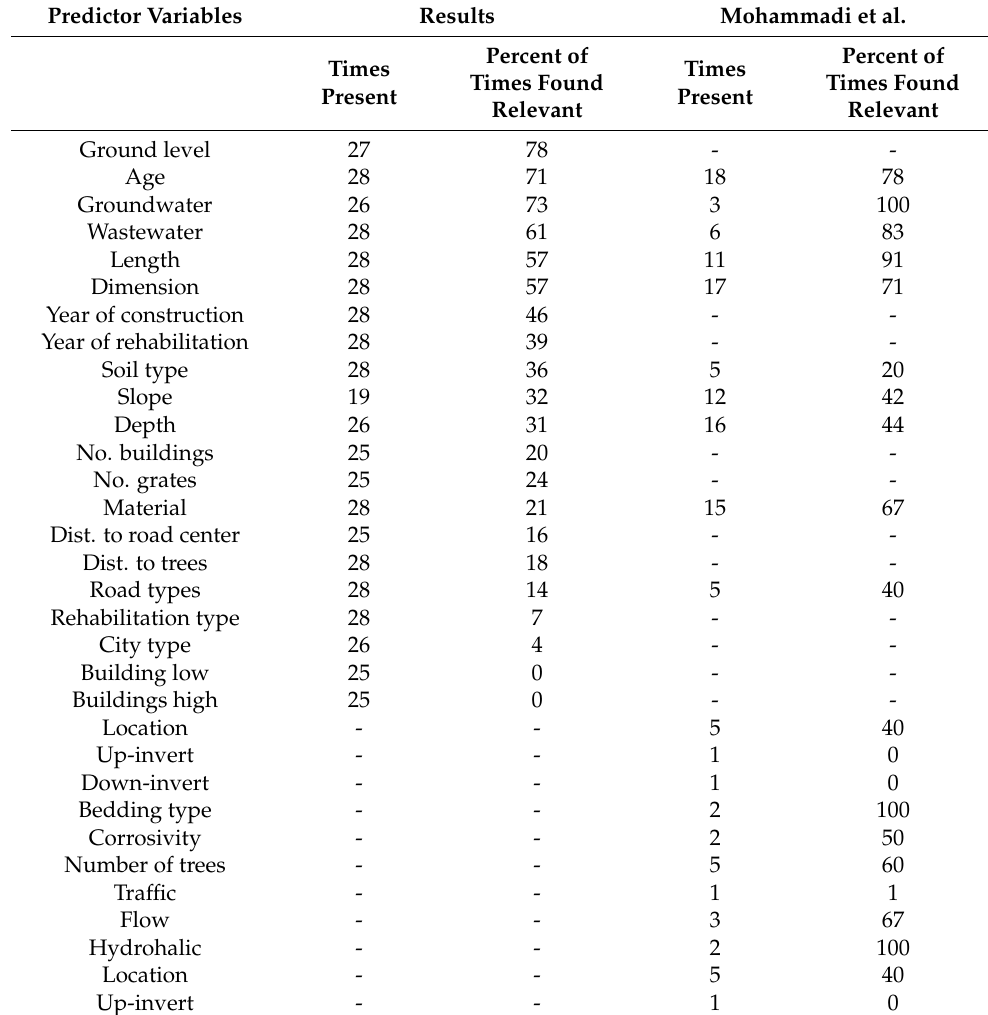
Table 6. Comparison of how often the different features contribute to the performance in this study and in the review by Mohammadi et